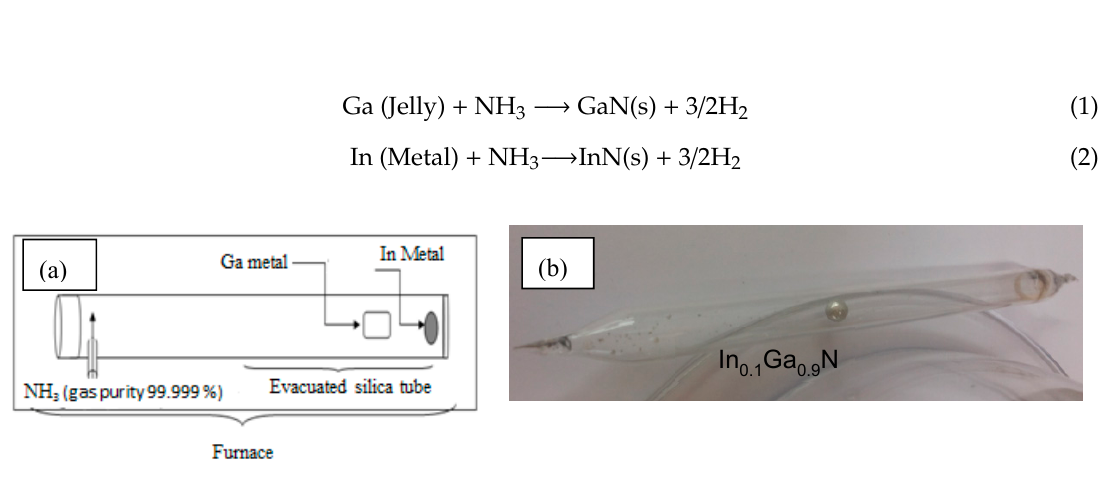
Figure 1. ( a ) Experimental setup. The tube contains In and Ga metals and NH 3 gas. ( b ) The resulting indium gallium nitride (In x Ga 1-x N) alloy after reaction.